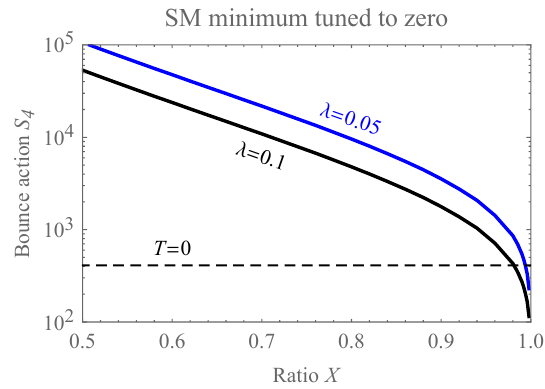
Figure 4 . Action of the bounce for quantum vacuum decay at zero temperature as function of the free parameter X de(cid:12)ned in eq. (2.15). Cosmologically fast rates are obtained for S 4 < (cid:24)